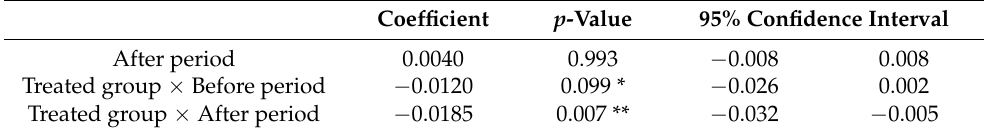
Table 3. Cont. Coefficient p -Value 95% Confidence Interval After period 0.0040 0.993 − 0.008 0.008 Treated group × Before period − 0.0120 0.099 * − 0.026 0.002 Treated group × After period − 0.0185 0.007 ** − 0.032 − 0.005 * p < 0.1; ** p < 0.05, ‘ × ’ indicates